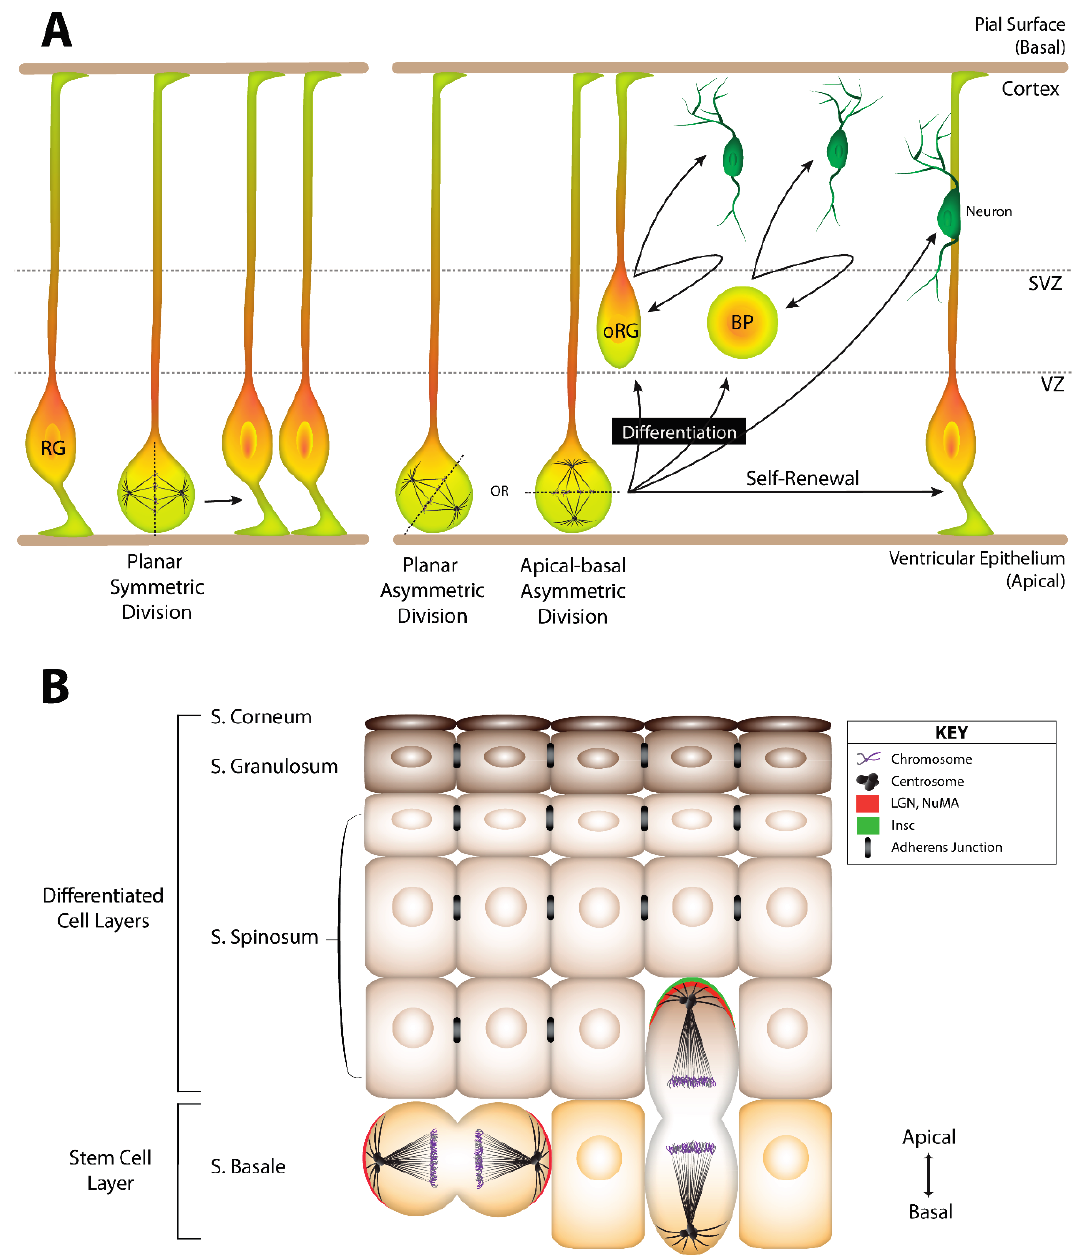
Figure 3. Oriented cell division in mammals. ( A ) Neurogenesis depends on properly balanced modes of division within radial glial progenitor cells (RG) within the ventricular zone (VZ). Planar symmetric divisions yield two RG cells, whereas asymmetric divisions drive differentiation within the subventricular zone (SVZ) and cortex. These asymmetric divisions are associated with altered spindle orientation relative to the overlying epithelium and produce outer RG (oRG), basal progenitors (BP), or neuron cells; ( B ) The mouse epidermis also relies on balanced output in mitotic symmetry for development of several differentiated layers. Keratinocyte stem cells in the basal layer undergo symmetric divisions in order to promote tissue growth and expansion. Insc expression induces an apical-basal orientation of cell division that allows for differentiation necessary for tissue stratification. The LGN/NuMA complex is critical for maintaining proper spindle orientation during this